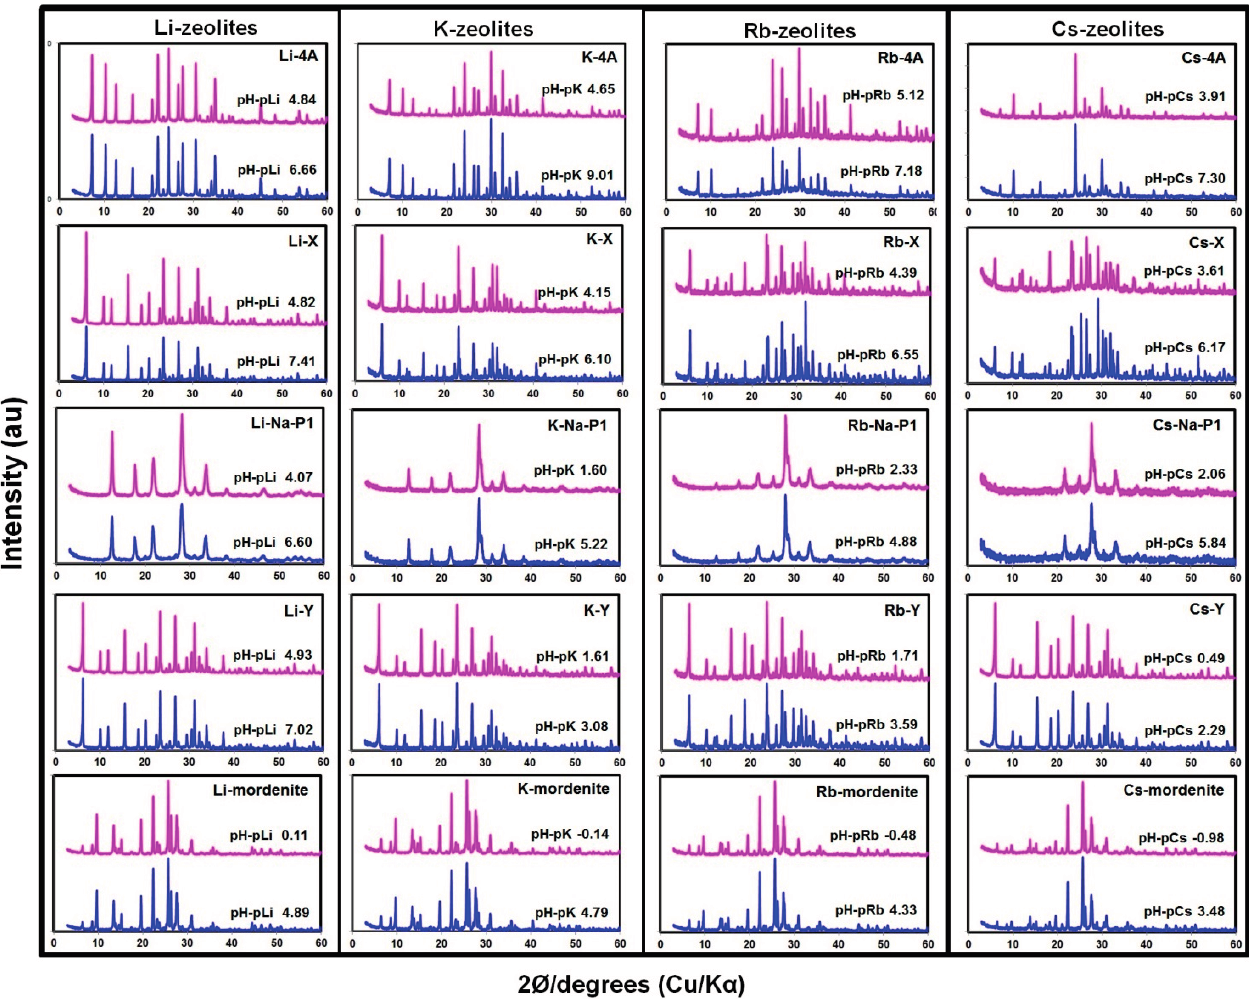
Figure 1. XRD patterns of zeolites after CEC